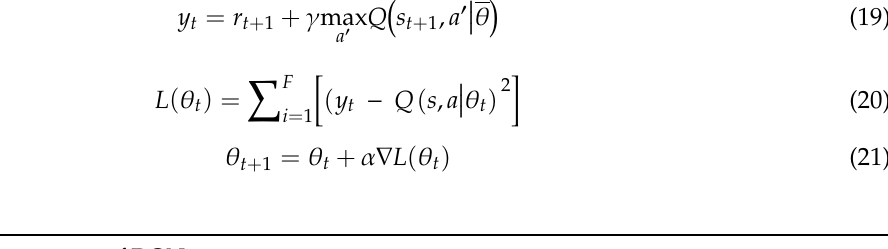
Algorithm 1. Training process of